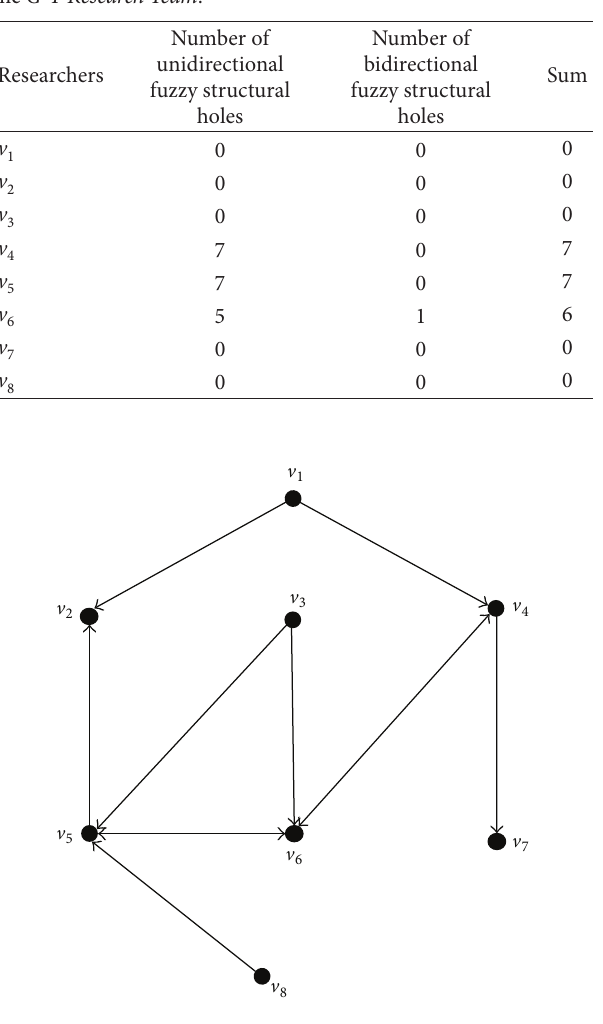
Figure 5: Directed fuzzy communication network of the G-Y Research